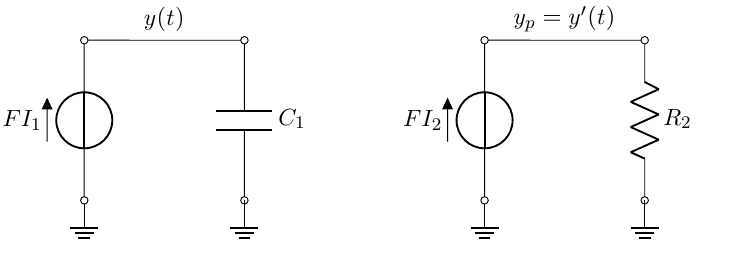
Figure 11. Circuit equivalent to equation Parabolic Mirror